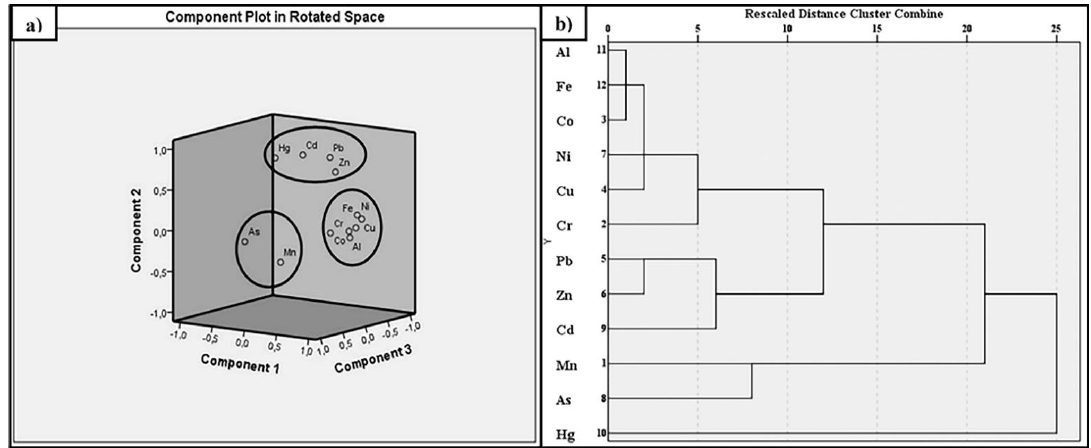
Figure 7. Principal component analysis ( a ) and multivariate hierarchical clustering ( b ) of the inves- tigated heavy metals from Lacu Sărat Lake